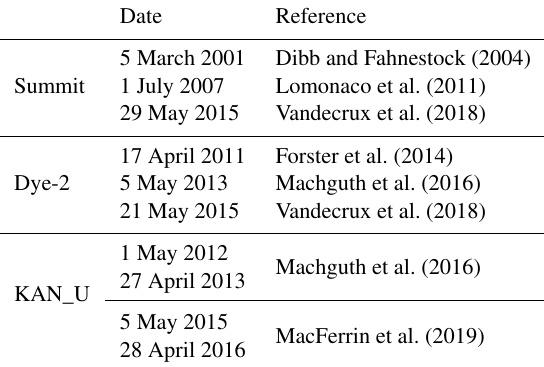
Table 4. Firn cores used for model